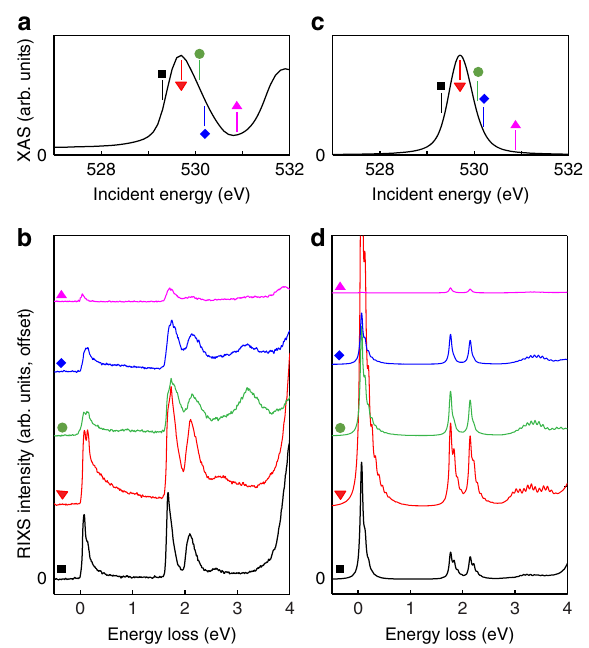
Figure 3 | The incident photon energy dependence of the RIXS spectra. ( a ) and ( c ) shows the measured and calculated XAS spectra, respectively. Calculations were performed using the model including coupling to the lattice. The measured and calculated RIXS spectra as a function of the incident photon energy are shown in ( b ) and ( d ), respectively. The RIXS spectra have been offset for clarity and the incident photon energy is indicated by the color-coded symbols in the corresponding XAS plots. The calculations have been broadened using a Gaussian line shape with a s.d. of